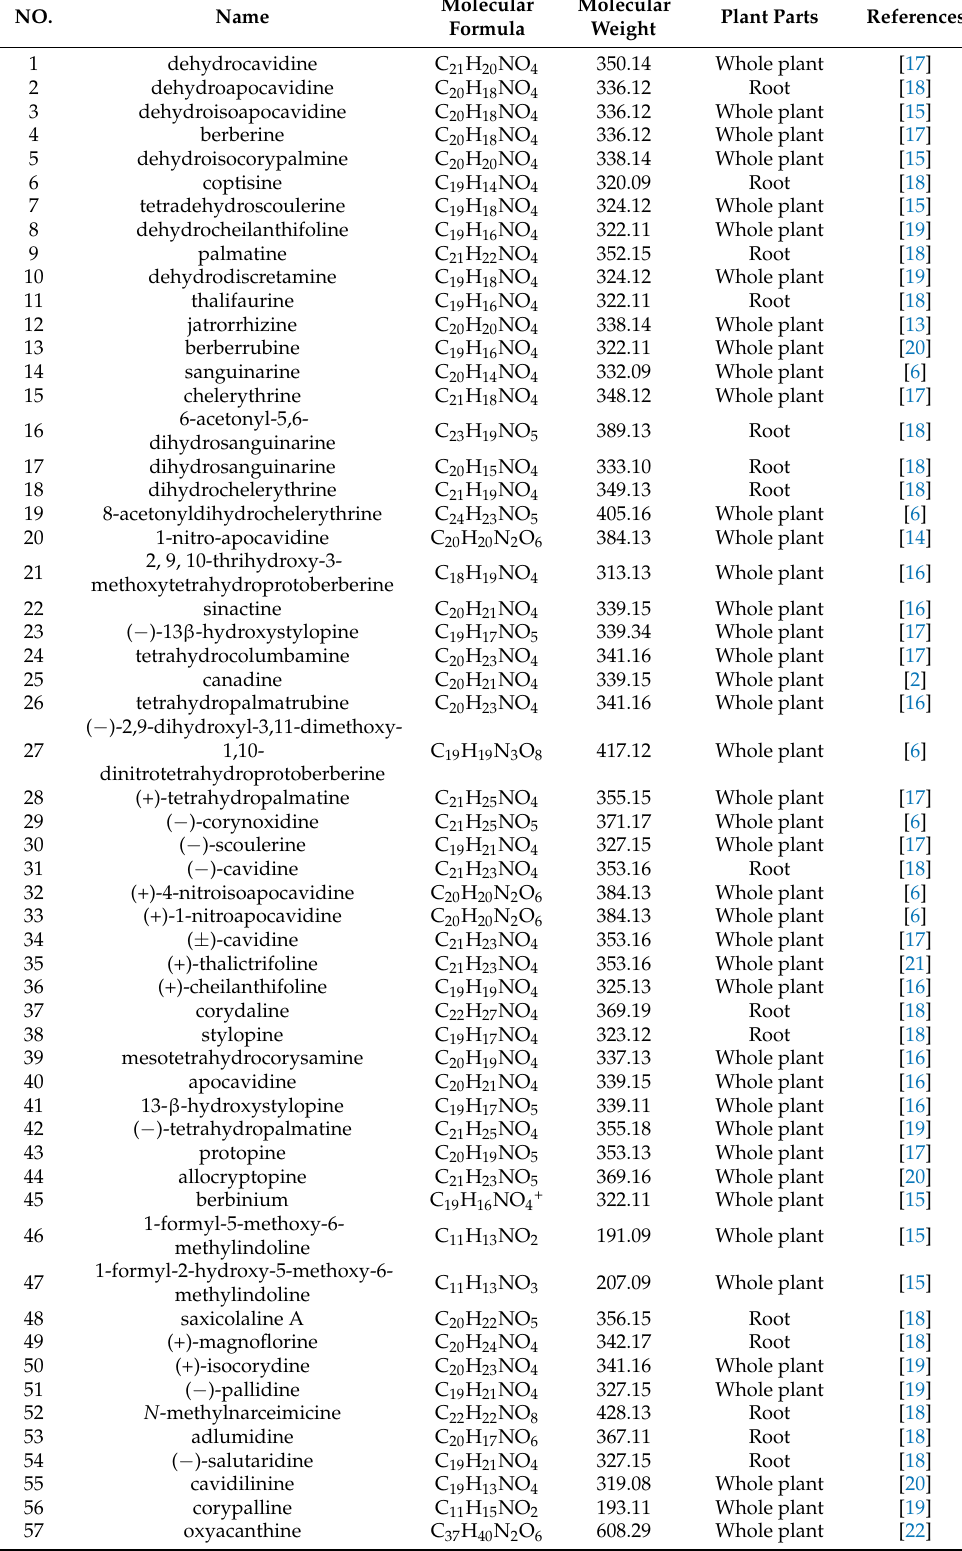
Table 1. The phytoconstituents isolated from Corydalis saxicola